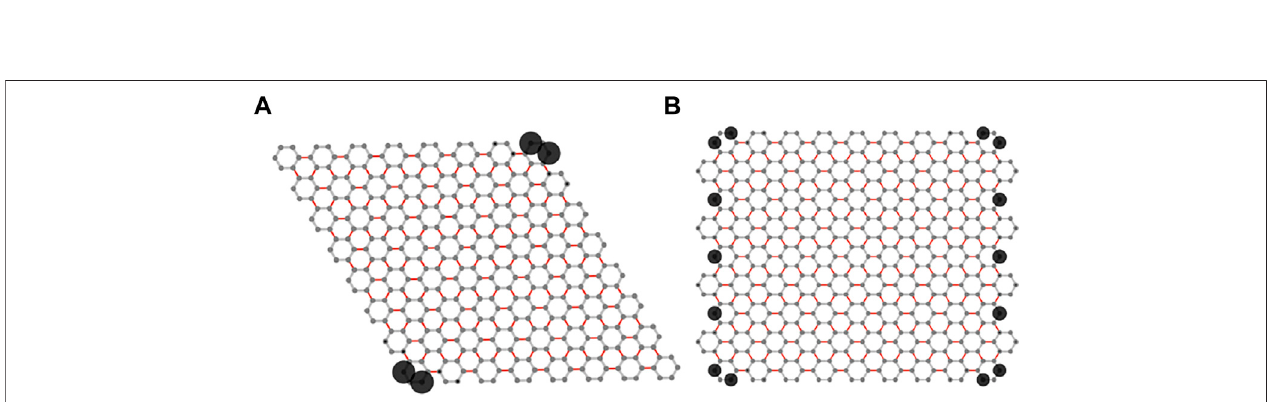
FIGURE3|(A – C) Possibletopologicalboundarymodesfortherhombic-shapedsamplewith10,×,10unitcells.Blackcirclesindicatethedistributionofdensityof zero-mode (A,C) Second-order TI phases with a single pair of zero-modes corners in diagonal and off-diagonal (or horizontal and vertical) directions, respectively. (B) Helical edge modes with the boundary effective mass m i = 0, which is a critical state separating two second-order TI phases. Parameters are set as (A) t 1 , 2 , 3 (cid:2) 1 , t 1 , 2 , 3 ′ (cid:2) 3, (B) t 1 (cid:2) 1 , t 2 (cid:2) 2 , t 3 (cid:2) 1 . 5 , t 1 , 2 , 3 ′ (cid:2) 3, (C) t 1 (cid:2) 1 . 8 , t 2 (cid:2) 0 . 2 , t 3 (cid:2) 0 . 8 , t 1 , 2 , 3 ′ (cid:2) 3.